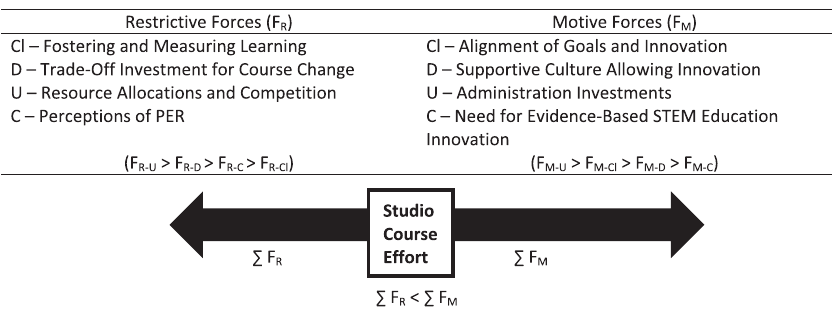
FIG. 7. Free body diagram summarizing the external forces influencing the studio physics program (Cl—classroom; D—department; U—university;